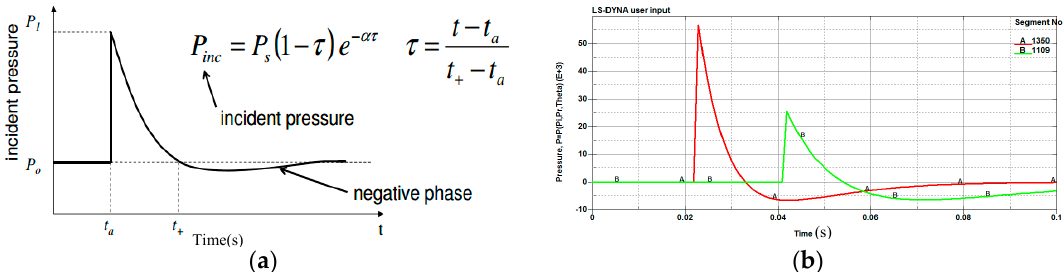
Figure 4. The plot of pressure vs. time in theory and numerical simulation. ( a ) The pattern of blast load, ( b ) The time history of blast load in simulation